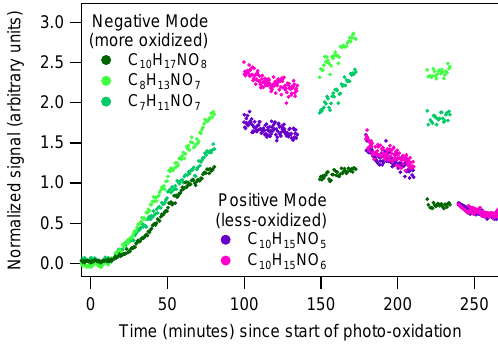
Figure 3. The organic nitrate loss rate as a function of relative humidity for Exps. 2, 4–12. Uncertainty (error bars) is estimated as 0.6 day − 1 , the highest loss rate observed in experiments below 5%RH (Exp.